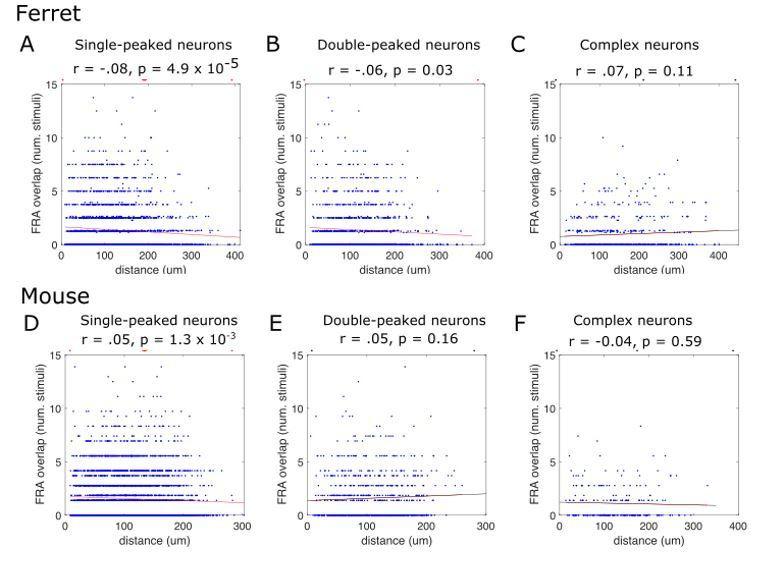
FRA overlap between pairs of simultaneously recorded neurons, plotted as a function of their distance along the tonotopic gradient.Y-axis shows the number of stimuli eliciting a response >50% maximum for both neurons in a given pair. Each blue dot represents a pair of neurons. The red line is the fitted linear regression, and statistics for the fit are provided below the titles above each plot. Results are plotted separately for ferrets (A, B, C) and mice (D, E, F), and for single-peaked (A, D), double-peaked (B, E) and complex (C, F) cells.